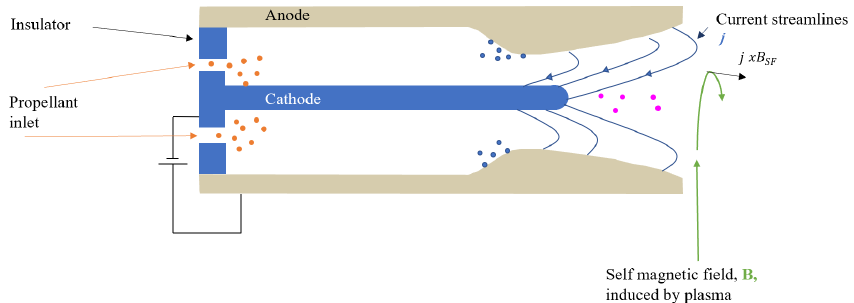
Figure 13. A Self Field MagnetoPlasmaDynamic Thruster as a simplified schematic